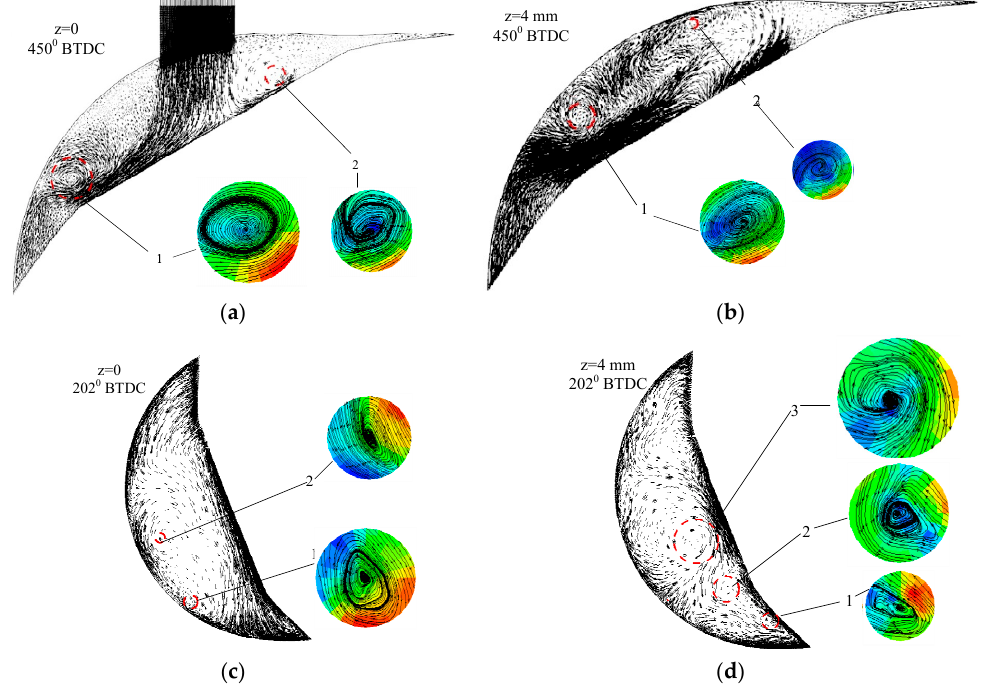
Figure 10. Velocity vector field on the z plane and streamlines in the vortex circle under different CA. ( a ) Z = 0 mm, CA = 450° BTDC; ( b ) Z = 4 mm, CA = 450° BTDC; ( c ) Z = 0 mm, CA = 205° BTDC; ( d ) Z = 0 mm, CA = 205° BTDC.